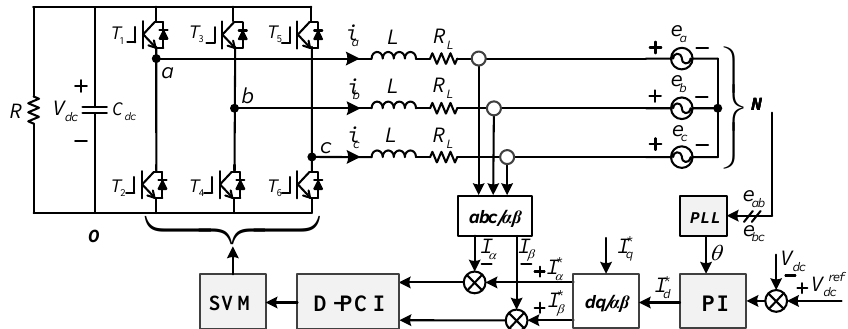
Figure 12. The double closed-loop control scheme of GC-VSC.